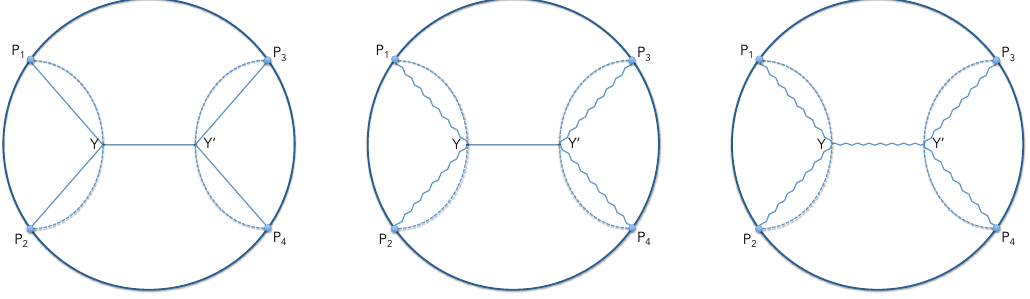
Figure 1 . Examples of geodesic Witten diagrams in AdS d +1 . The doted line indicates that we are projecting the propagators over a geodesic that connects the endpoints. Straight lines correspond to scalar (cid:12)elds, while wavy lines are symmetric traceless tensors of spin J . The (cid:12)rst diagram corresponds to the scalar block in (3.1). The middle diagram (with scalar propagator in the exchange) will be the focus of section 3.1 and the last diagram (with a spin- J (cid:12)eld exchanged) is the focus of section